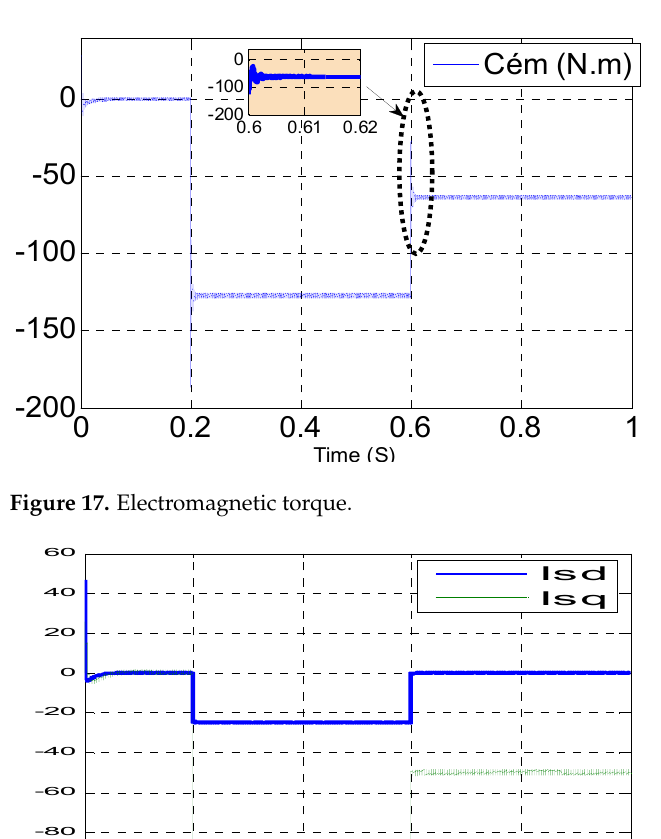
Figure 16. Direct currents and rotor quadrature.